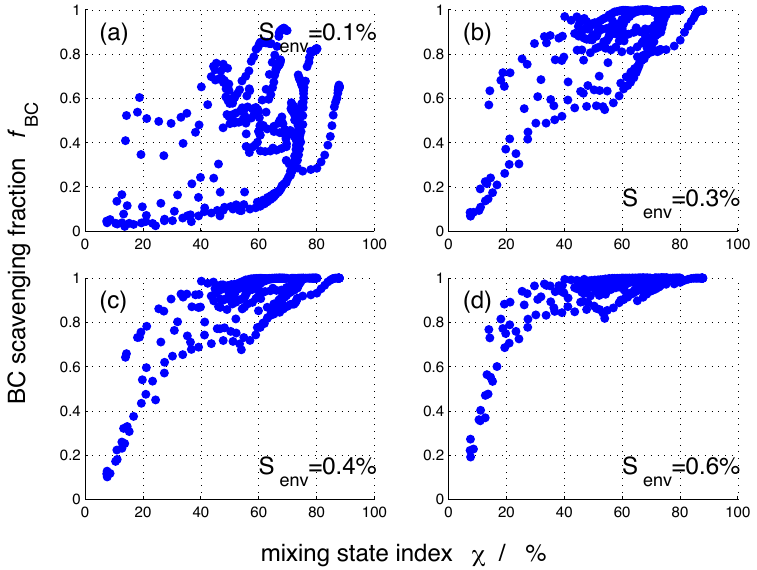
Figure 6. Nucleation-scavenged BC mass fraction, f BC , for the 384 aerosol populations for selected supersaturations as a function of mixing state index χ . The definition of mixing state index is described in Section